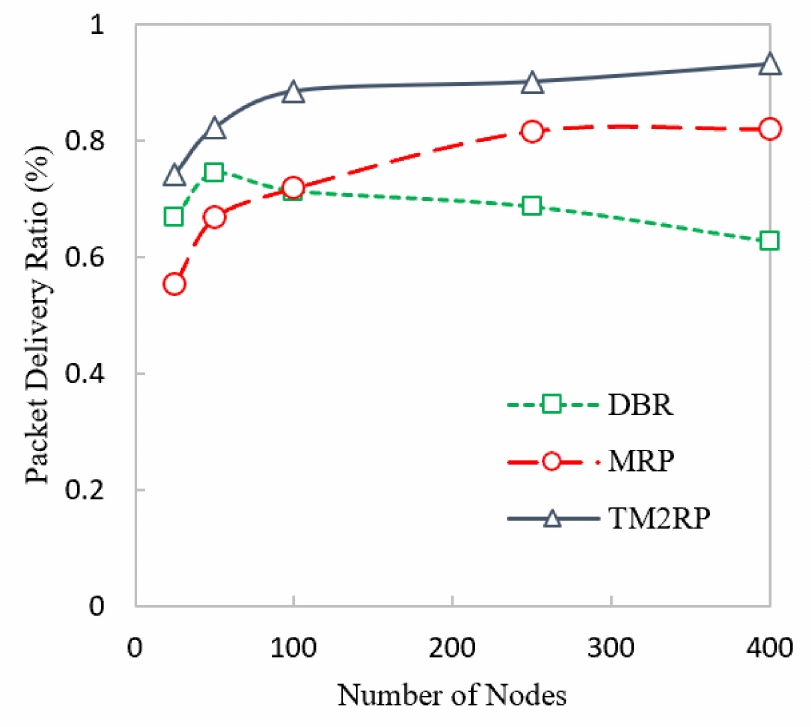
Figure 9. Comparison of underwater packet delivery ratio with increasing number of